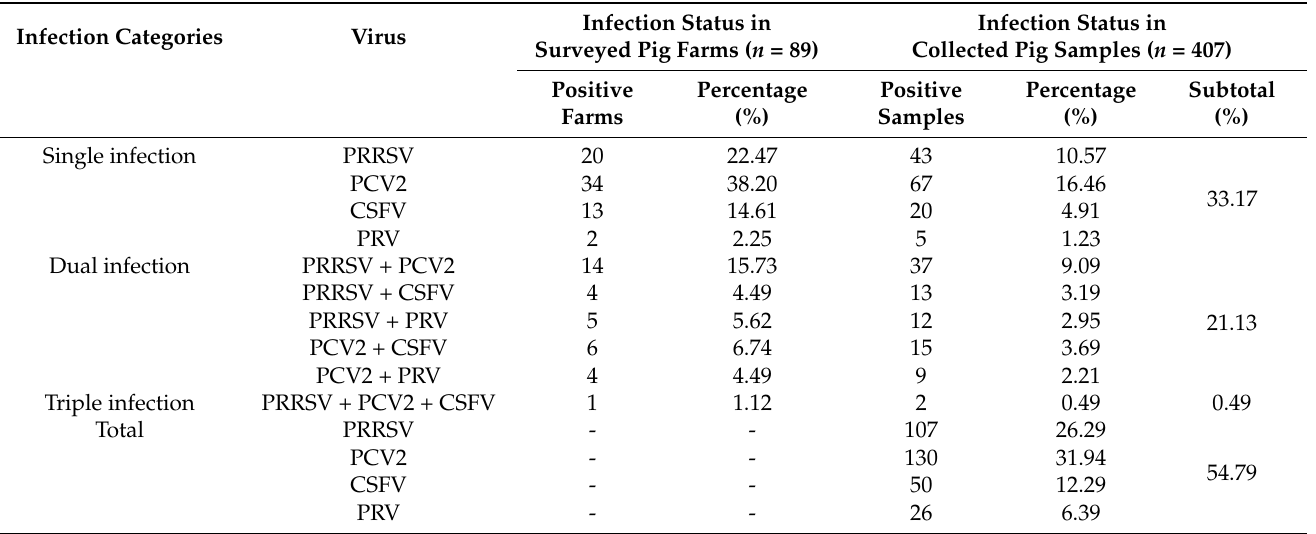
Table 2. Infection status of four viruses in 407 aborted-fetus samples collected from 2019 to 2021 in Hunan